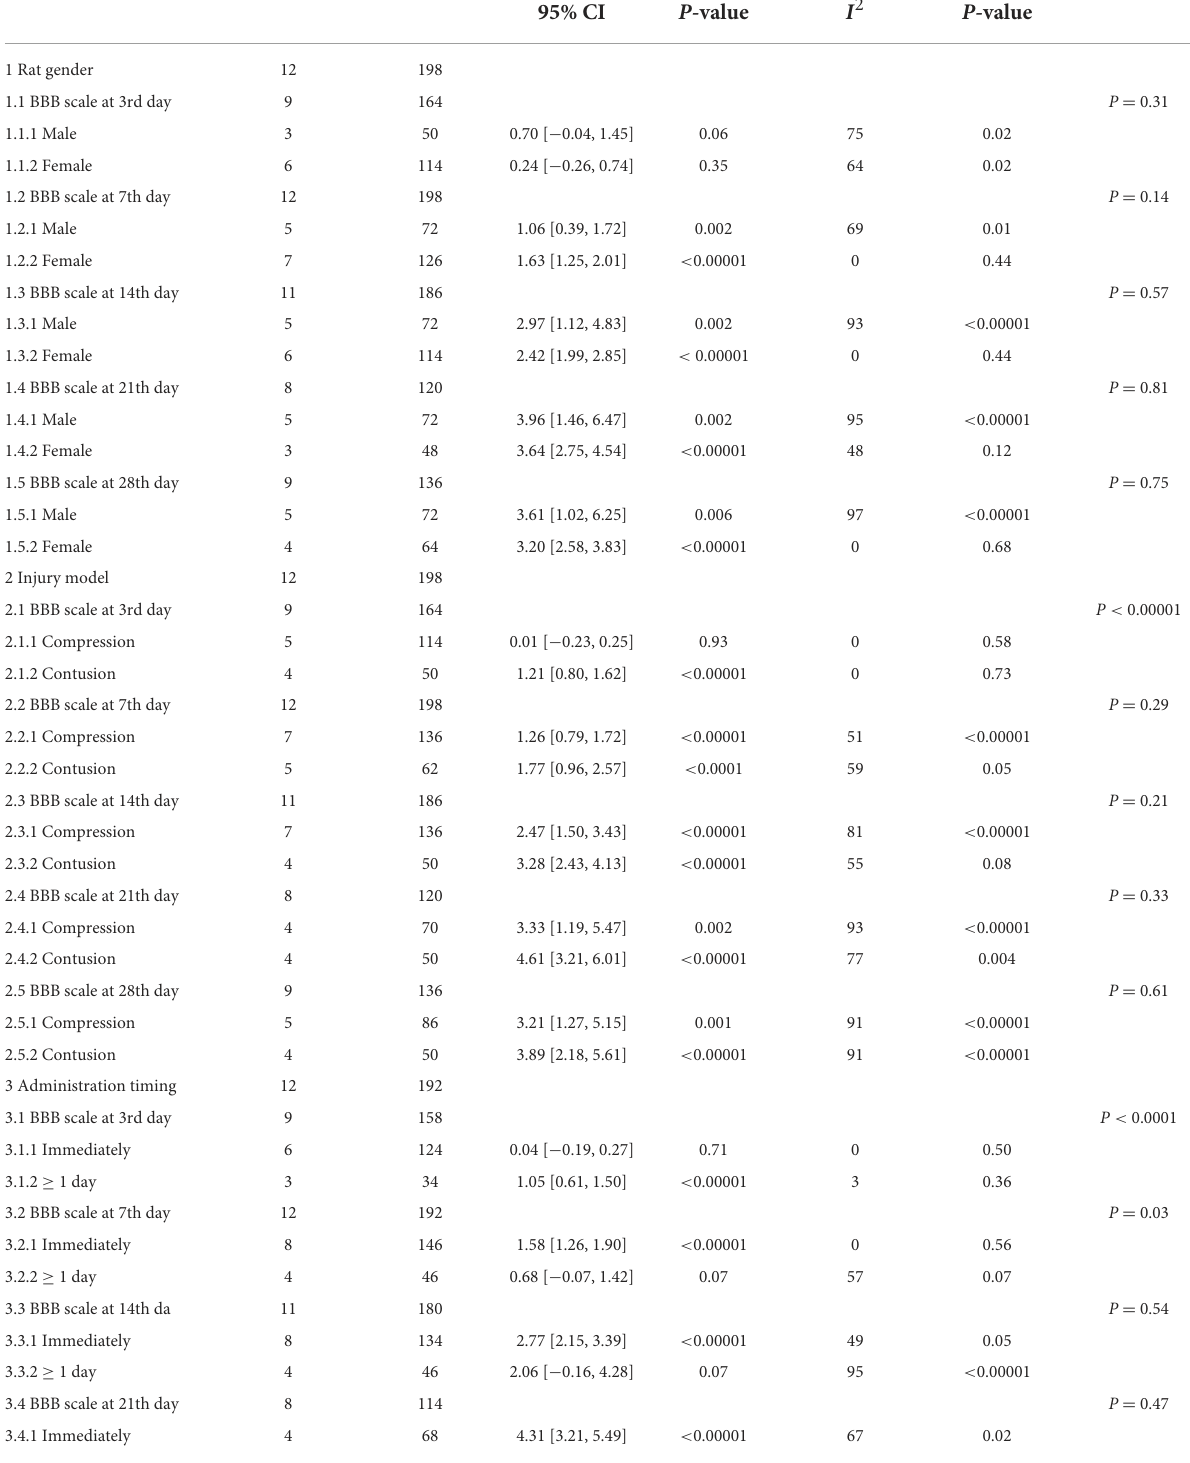
TABLE 5 Subgroup analyses of the effects of